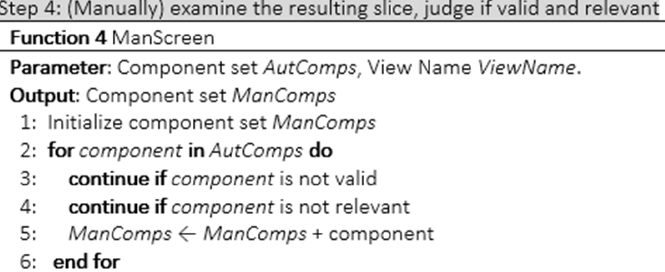
Figure 3. Pseudo-codes for the automatic searching algorithm (Step 3).